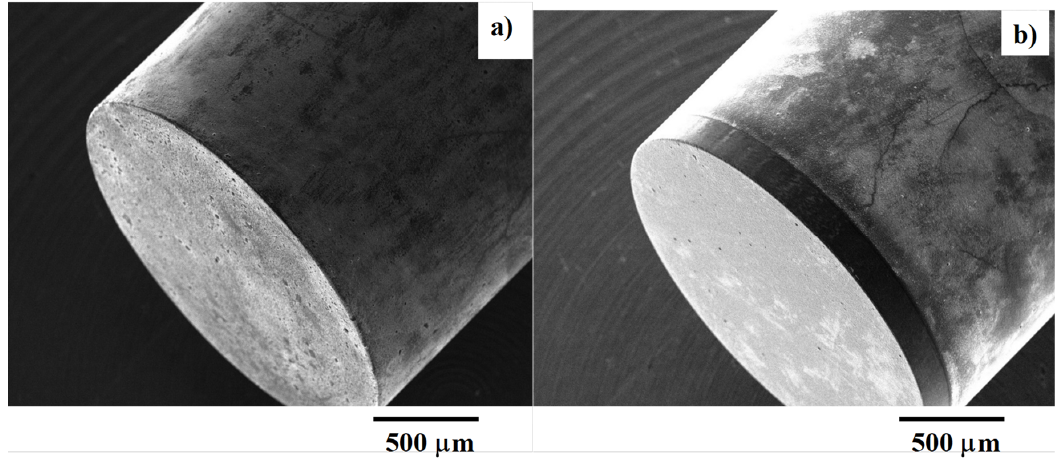
Figure 4. Comparison of CVD (Chemical Vapor Deposition)-diamond coated WC (Co) punches before and after femtosecond laser trimming: ( a ) before trimming and ( b ) after trimming.